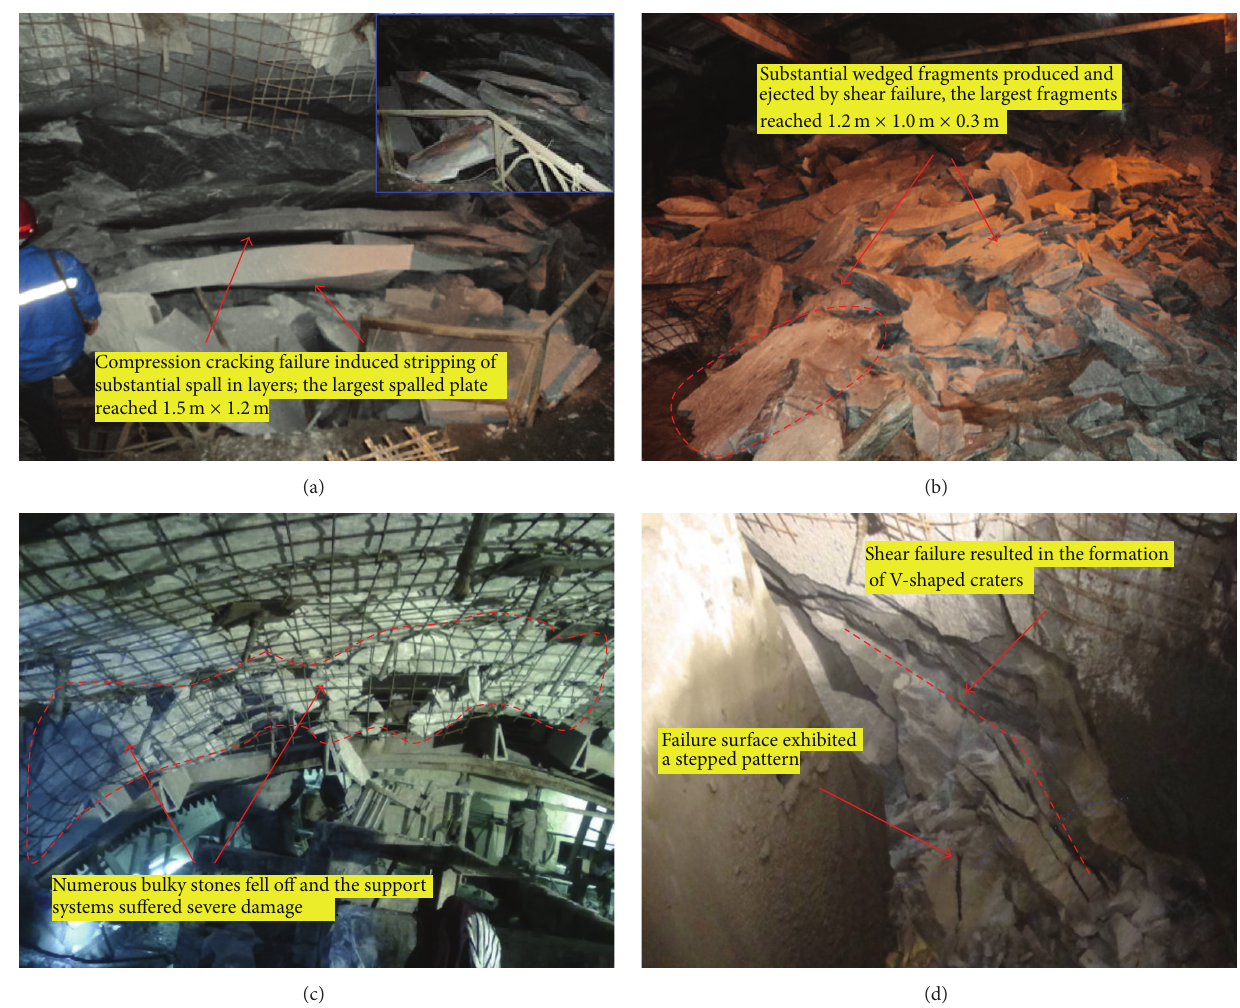
Figure 11: On-site photos showing the failure caused by rockburst. (a) Compression cracking failure induced stripping of substantial spall in layers. (b) Substantial wedged fragments produced by shear failure were ejected to a certain distance. (c) The anchoring-shotcreting and flexible support systems suffered severe damage. (d) Rockburst failure resulted in the formation of V-shaped craters.